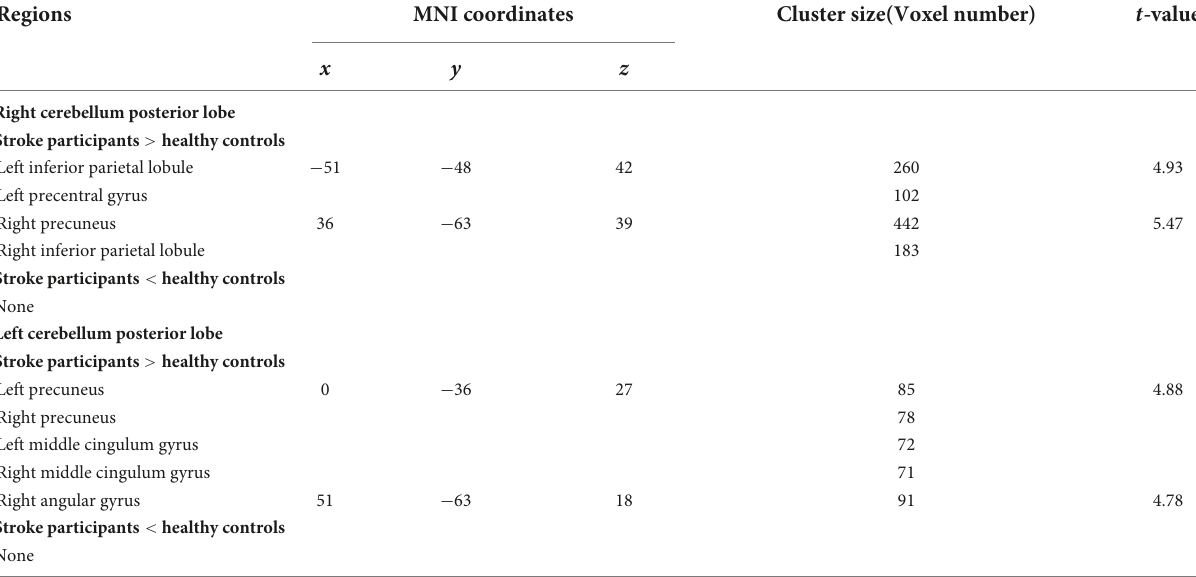
TABLE 3 Regions showing significantly different functional connectivity (FC) in cerebellum posterior lobe (CPL) between the stroke participants and healthy controls. Regions MNI coordinates Cluster size(Voxel number) x y